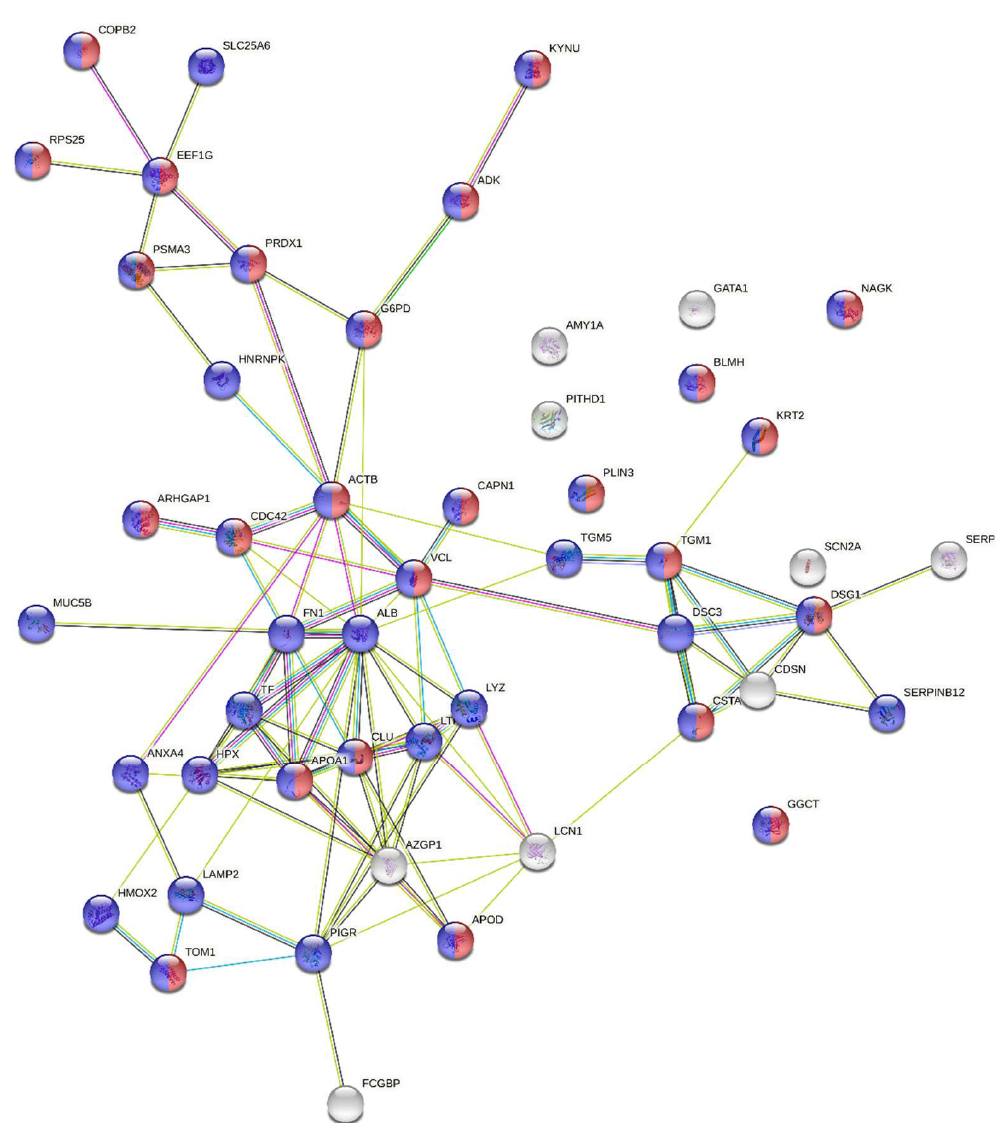
Figure 4. Bioinformatic characterization of proteins present in the EBC at higher amounts after PE ( n = 50). The number of edges is 98. For a random set of 50 proteins, 34 edges would be expected. The number of interactions is significantly higher than expected (protein–protein interaction enrichment p -value < 1 × 10 − 16 ). Blue nodes: cytoplasm proteins (41). Red nodes: cytosol proteins (25). The protein–protein interaction enrichment p -value was estimated based on a Random Graph with Given Degree Sequence (RGGDS), as described in